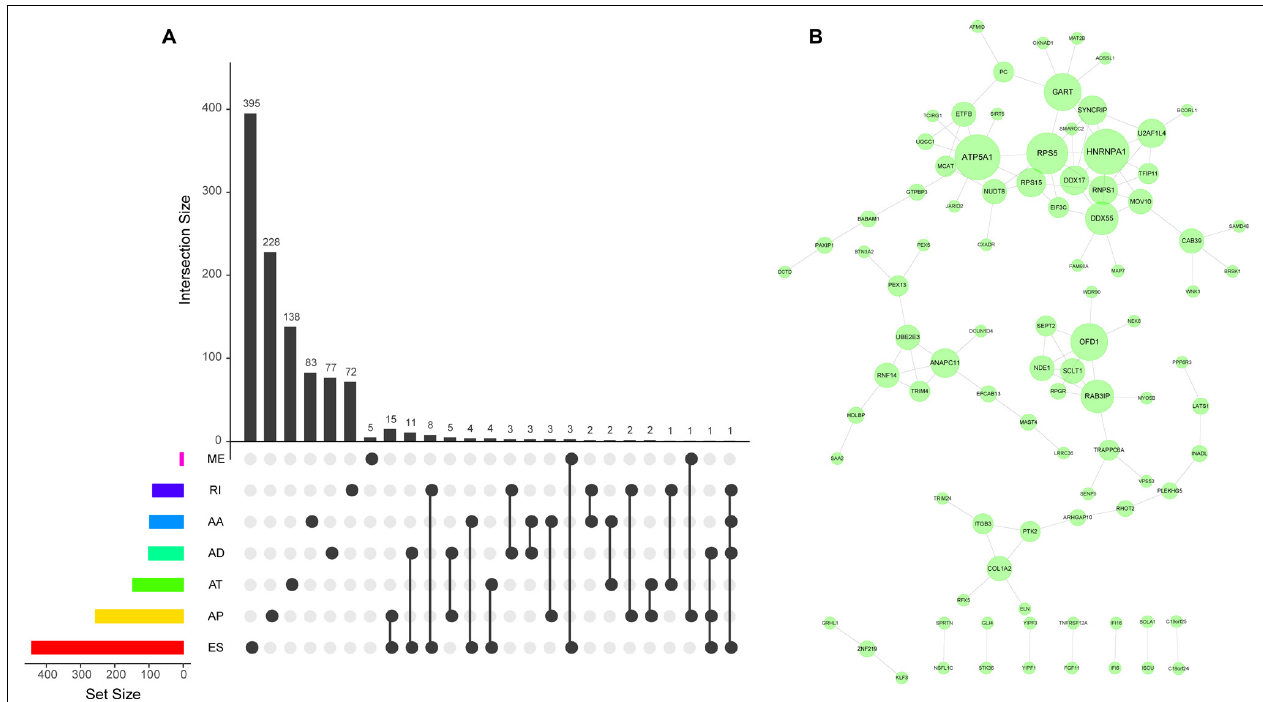
FIGURE 2 | UpSet and gene interaction network plots of prognosis-associated AS events in TNBC. (A) The UpSet intersection plot between the seven types of prognosis-associated AS events and genes. One gene may have up to four types of AS events. (B) Gene interaction network for prognosis-associated AS events. This plot was generated by cytoscape, nodes stood for genes, lines denoted interactions, and the size of the nodes represented degrees.